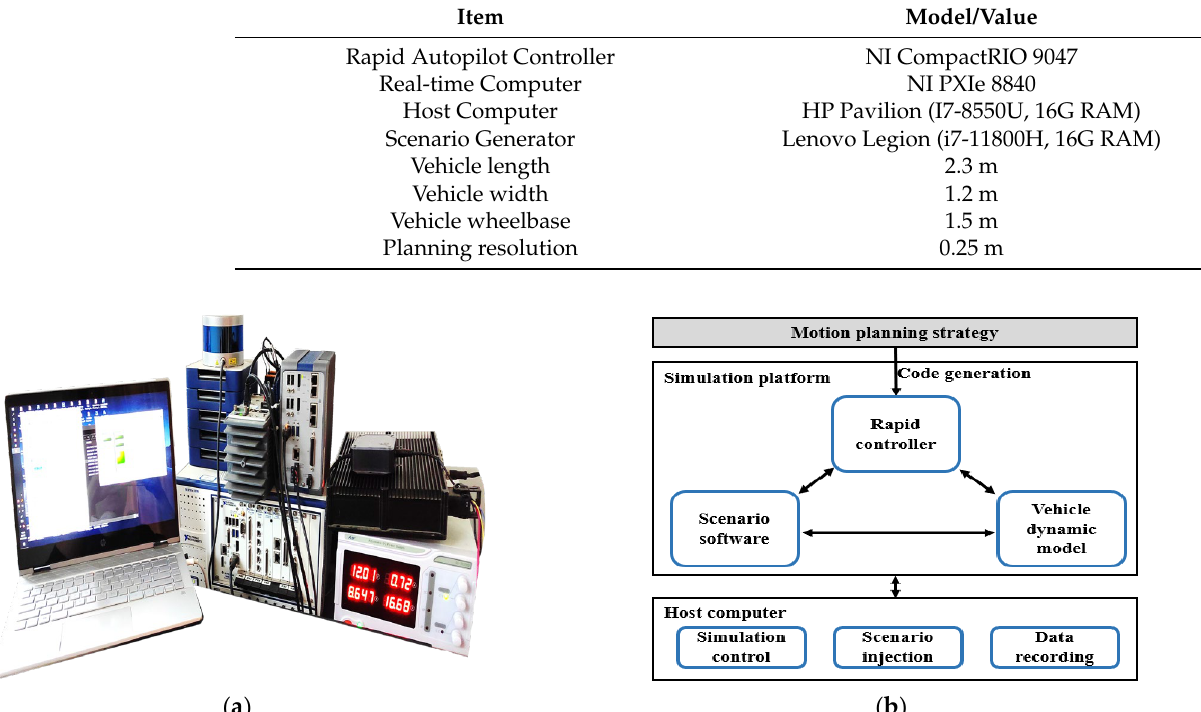
Table 1. Simulation parameters.